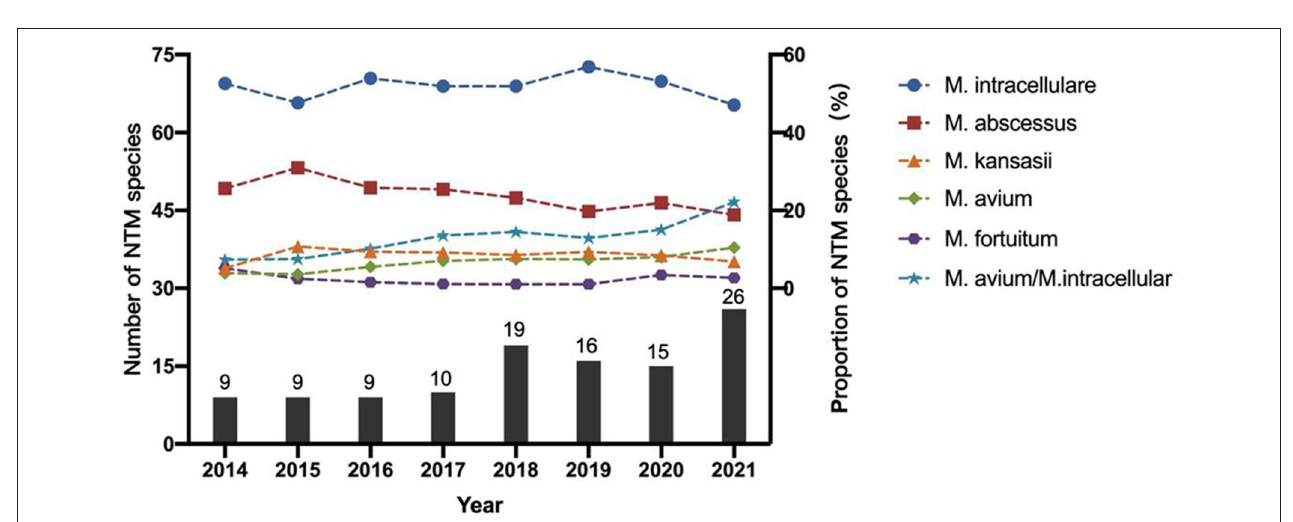
FIGURE 3 | The trends of major NTM species among all the NTM strains between 2014 and 2021.